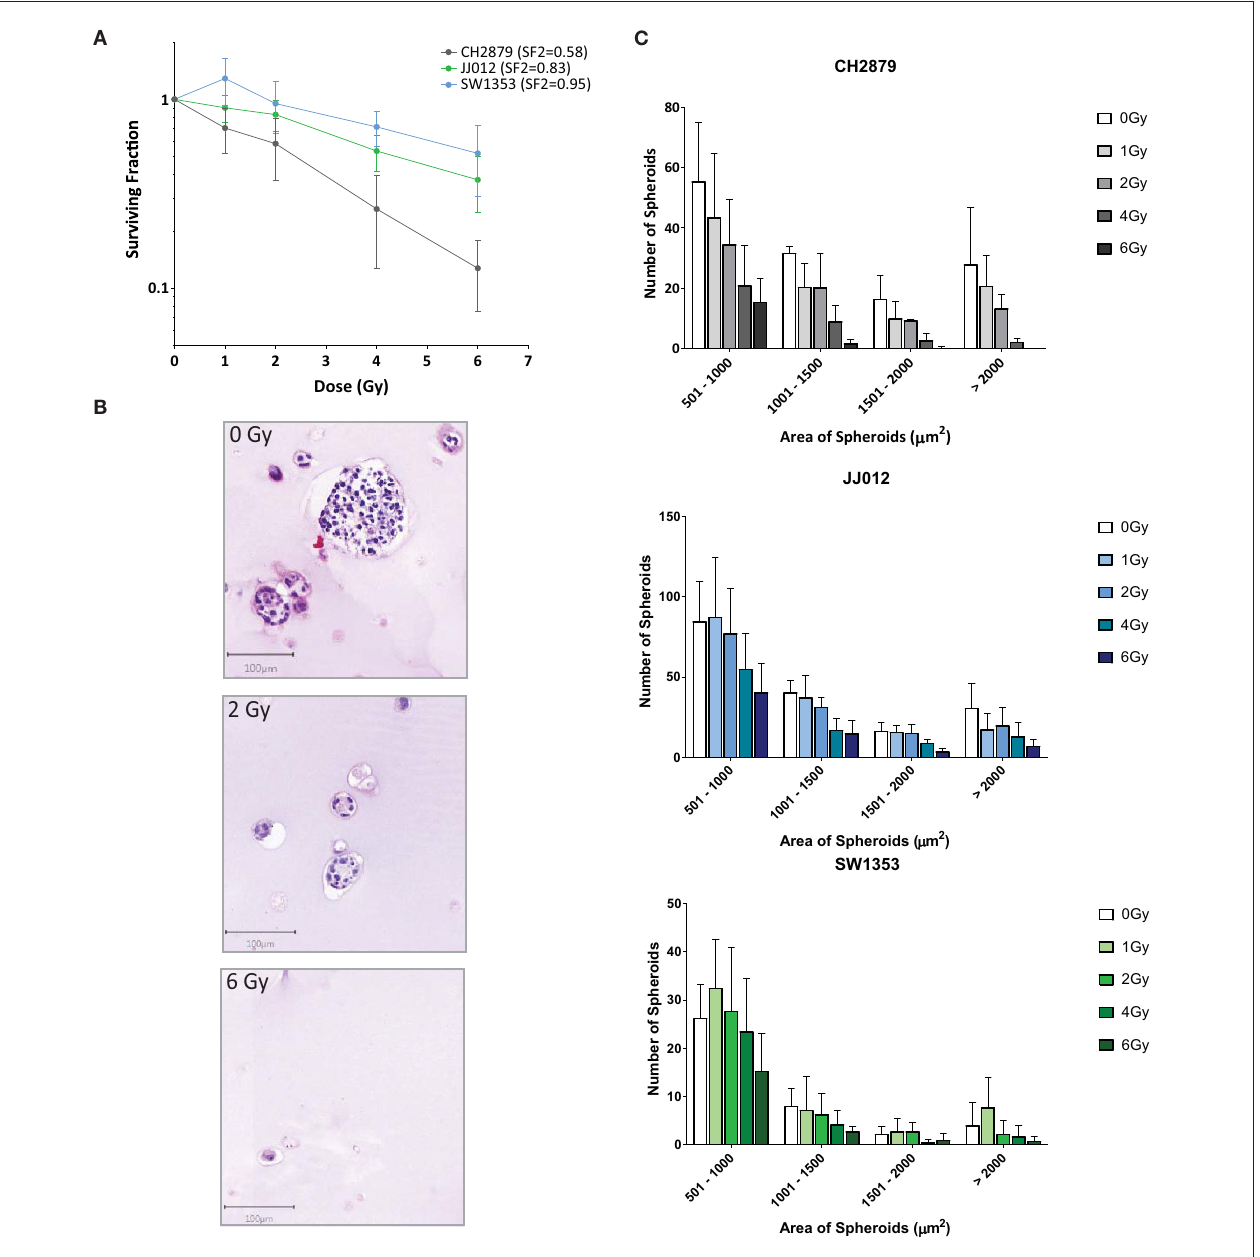
FIGURE 7 | Chondrosarcoma spheroids were irradiated with indicated doses and response evaluated by 3D colony formation assay ( n = 4). (A) All three cell lines were sensitive to radiation at higher dosages ( > 2Gy), however CH2879 also showed sensitivity at lower doses (SF2 = 0.58). (B) CH2879 spheroid colony number and size decrease with increased radiation dose (C) Spheroid area (size) was also reduced with increased